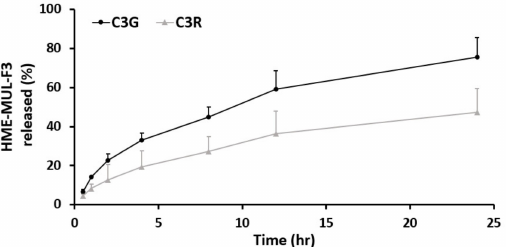
Figure 4. Release profile of ACN (C3G and C3R) from MUL, HME-MUL and HME-DDS (HME- MULF1, F2, F3) in gastrointestinal tract simulation. SGF: simulated gastric fluid, from initial and 2 h (0, 0.5, 1, and 2 h), SIF: simulated intestinal fluid from 2 to 24 h (2, 4, 8, 12, and 24